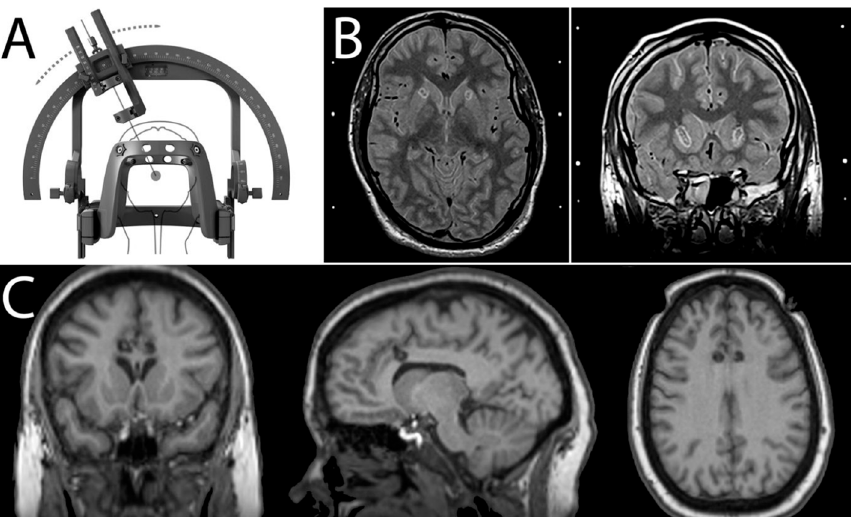
Figure 1. ( A ) Stereotactic frames use a specific coordinate system to define and provide surgical access to any point in the brain in three-dimensional space (Leksell ® VantageTM Stereotactic System-image courtesy of Elekta). ( B ) Axial and coronal stereotactic proton-density-weighted MR images immediately after anterior capsulotomy. The lesions can be seen as a hypointense area of tissue necrosis surrounded by a hyperintense region of oedema. ( C ) Coronal, sagittal, and axial stereotactic T1-weighted MR images immediately after anterior cingulotomy. (Fiducial markers have been cropped out of the original images.) The lesions can be seen as a hypointense area.